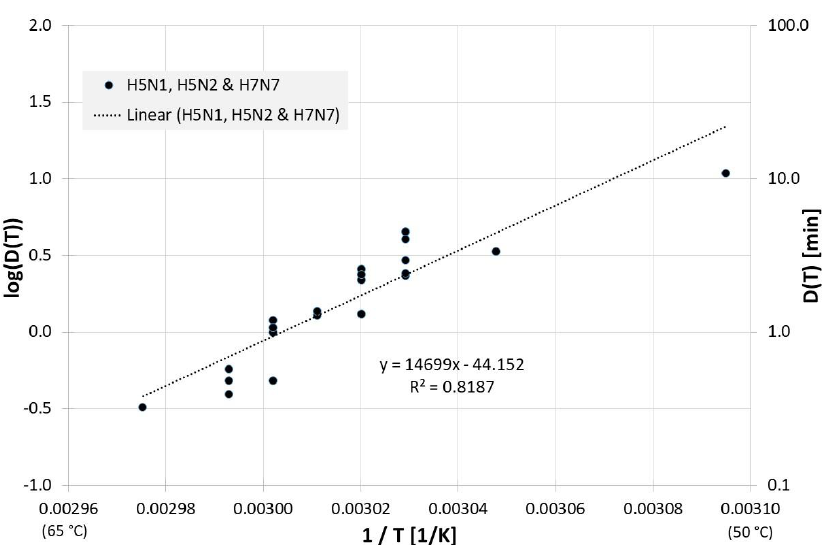
Figure 6. Correlation between 1/T and log(D(T)) for all published influenza virus thermal inactivation data in chicken meat along with the linear regression curve. For better understanding, D(T) is also given on the right Y-axis in a logarithmic scale.